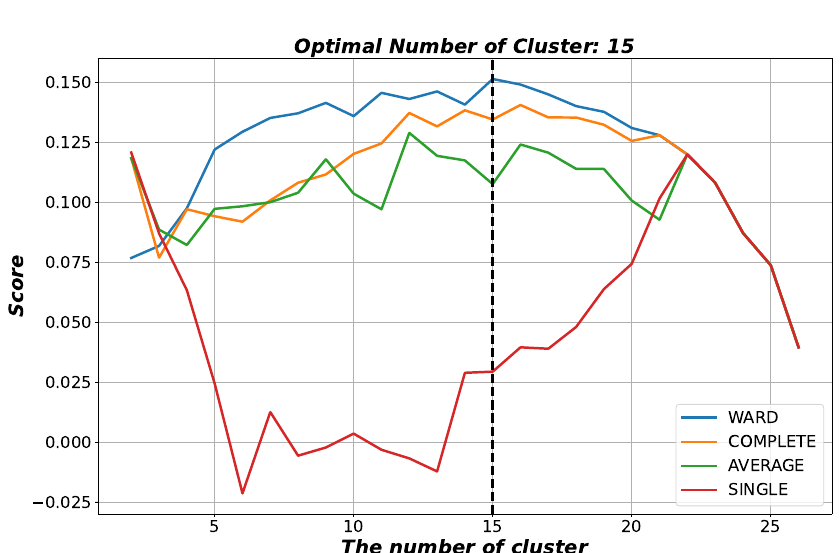
Figure 6. Determining the optimal number of clusters using silhouette scores of four